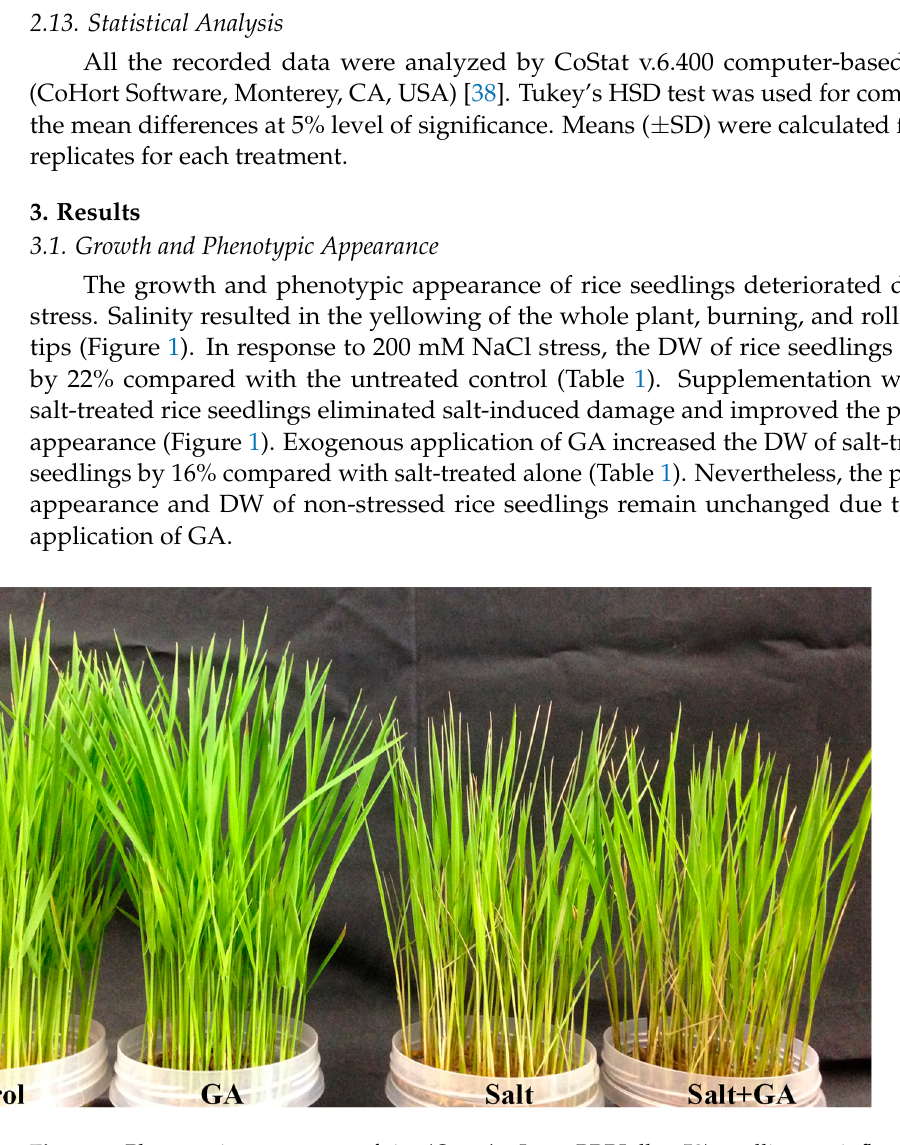
Figure 1. Phenotypic appearance of rice ( O. sativa L. cv. BRRI dhan52) seedlings as influenced by GA under salt stress. 1 mM gallic acid and 200 mM NaCl are specified by GA and salt, correspond-ingly. Table 1. Dry weight, leaf RWC, proline content, osmotic potential, MDA content, and H 2 O 2 content of salt-treated rice ( O. sativa L. cv. BRRI dhan52) seedlings as influenced by GA supplementation.